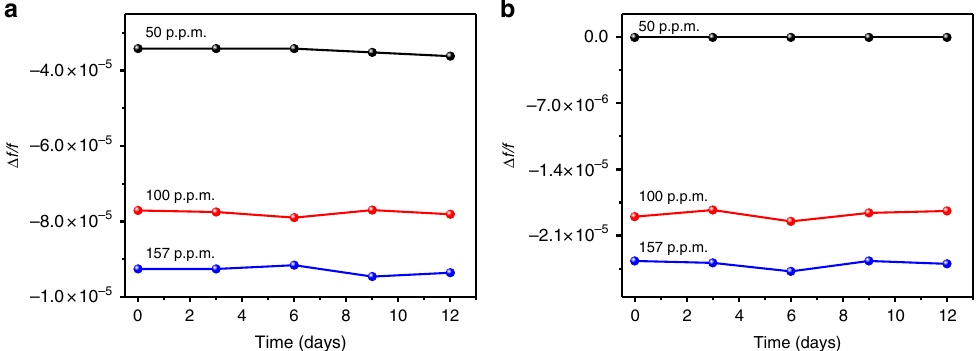
Fig. 8 Stability and reproducibility. Long-term stability property of the a KAUST-7 and b KAUST-8 sensors exposed to 50, 100, and 157 p.p.m. SO 2